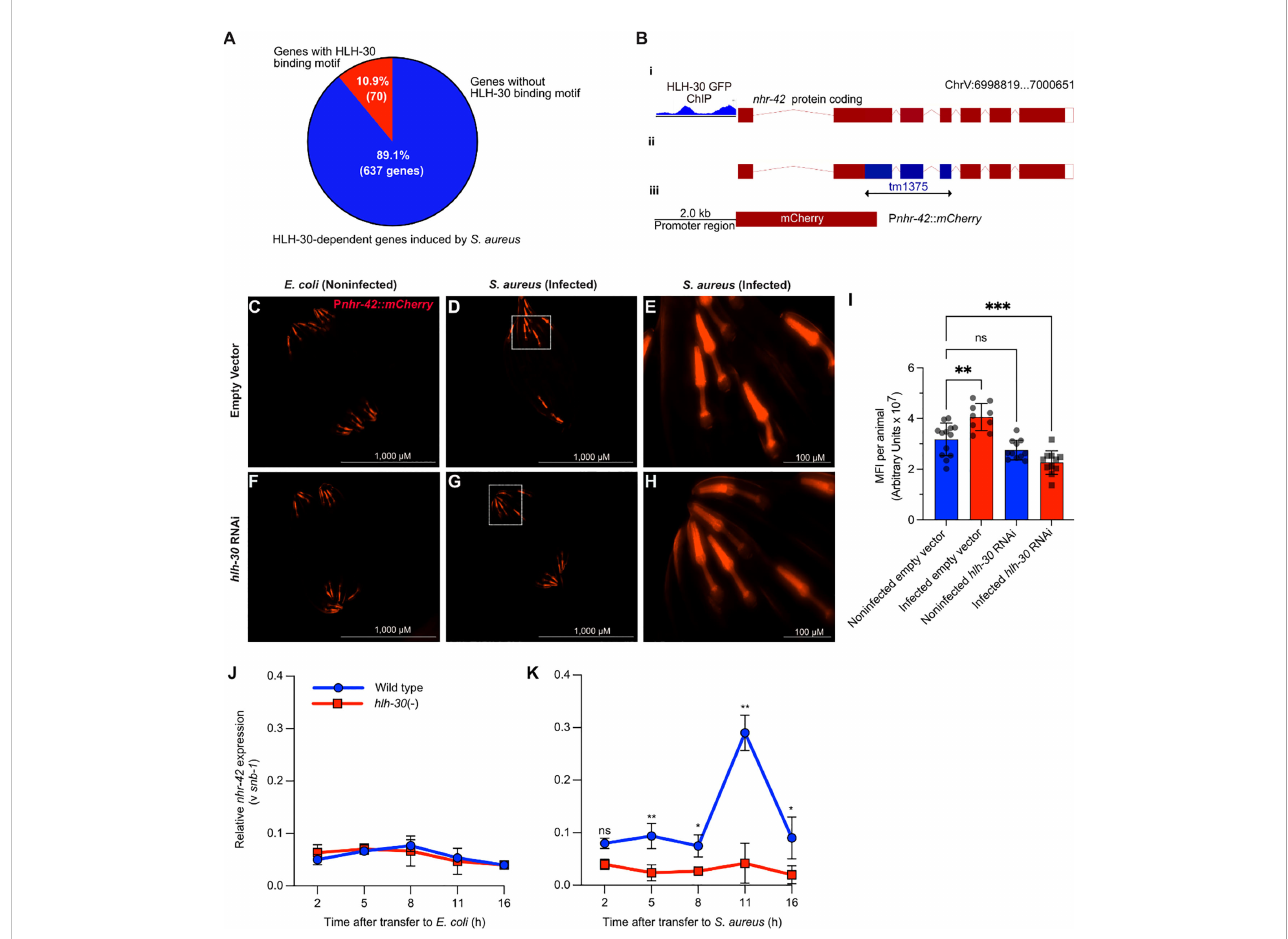
FIGURE 1 S. aureus induces nhr-42 in an hlh-30 -dependent manner (A) Pie chart depicting predicted genes directly induced by HLH-30 during S. aureus infection [Original data are from (8)]. (B) Cartoon depicting the nhr-42 locus on Chromosome V, highlighting i) promoter region containing HLH-30 ChIP-seq peaks within 2 kbp of the transcription start site [original data from (37), ii) tm1375 deletion of 451 bp spanning exons 2-4,and iii) P nhr-42::mCherry transcriptional reporter construct from this study. (C – H) Epi fl uorescence micrographs of P nhr-42 :: mCherry animals fed E. coli , expressing RNAi empty vector or hlh-30 dsRNA, and then exposed to E. coli OP50 (C, F) or to S. aureus SH1000 (D, G) for 24 h. E and H show magni fi ed areas of D and G, respectively. Scale bars: 1,000 µm for images (C, D, F, G) , and 100 µm for E and (H) . Data are representative of 2 independent replicates. (I) Quanti fi cation of mean fl uorescence intensity (MFI) per animal from (C – H) . n = 10 -20. ** P ≤ 0.01, **** P ≤ 0.0001. ns, not signi fi cant. One-way ANOVA with S ̌ ı ́ da ́ k ’ s post-hoc test. (J – K) RT-qPCR of nhr-42 transcript in wild type and hlh-30 (tm1978) mutants fed E. coli OP50 (J) or infected with S. aureus (K) . * P ≤ 0.05, ** P ≤ 0.01. ns, not signi fi cant. 2- sided 2-sample unpaired t -test. 2-4 biological replicates. N = ~1,000 animals per